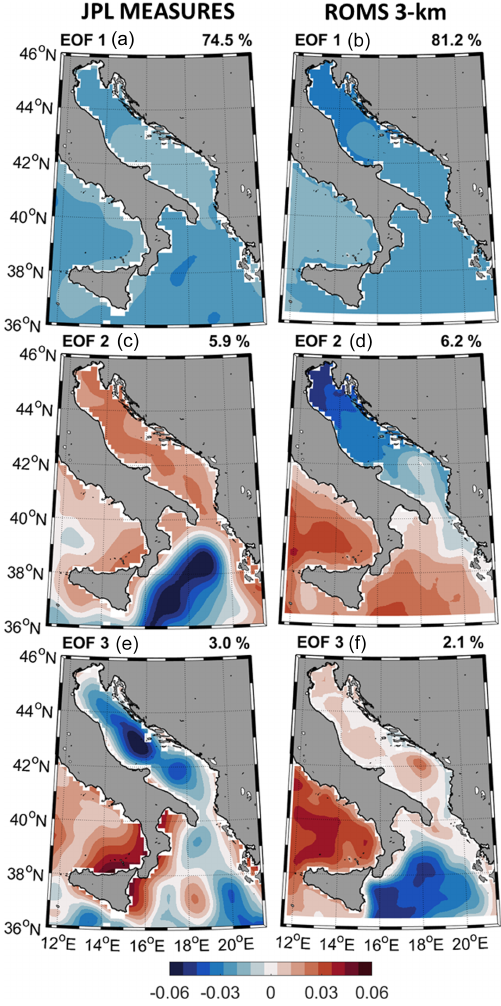
Figure 2. Three main normalized spatial EOF components derived during the 1993–2017 period from the SSHA from the JPL MEA- SURES gridded product (a, c, e) and the SSH results of the AdriSC ROMS 3km model (b, d, f)